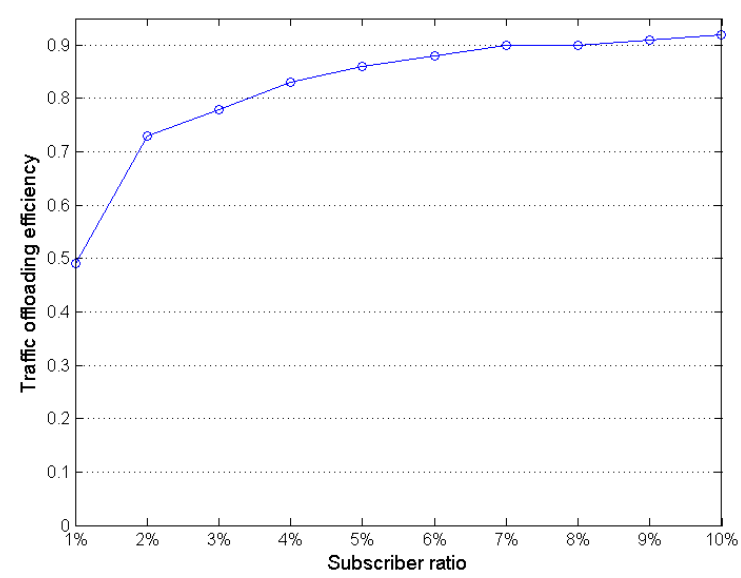
Figure 6. Traffic offloading ratios under different subscriber ratios.